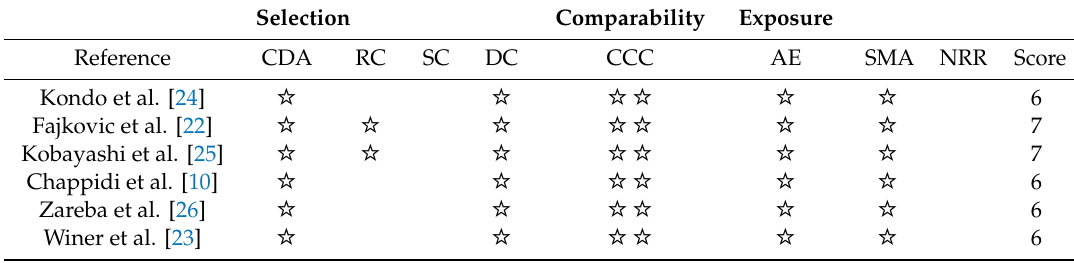
Table 2. Assessment of the quality of the non-radomized controlled trial (RCT) studies using the Newcastle–Ottawa scale for case-control studies.